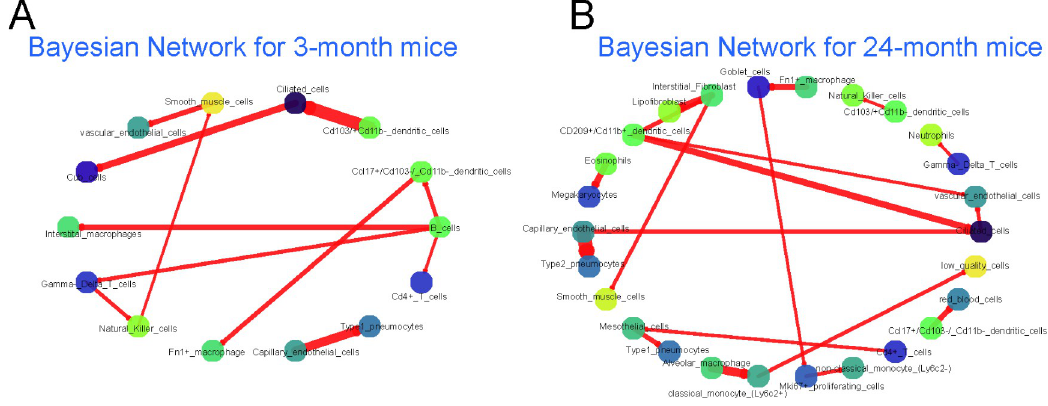
Fig 4. Aging Bayesian Networks. (A) BN for young mice. B) BN for adult mice. Nodes and edges notations and colorings are similar to those used in Fig 2